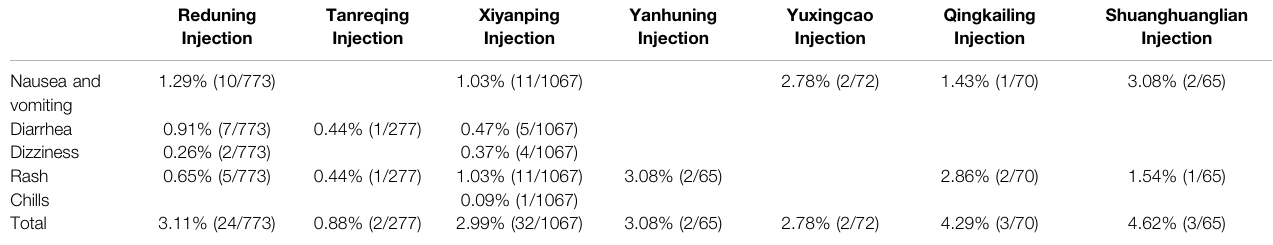
TABLE 3 | Details of adverse drug reactions.